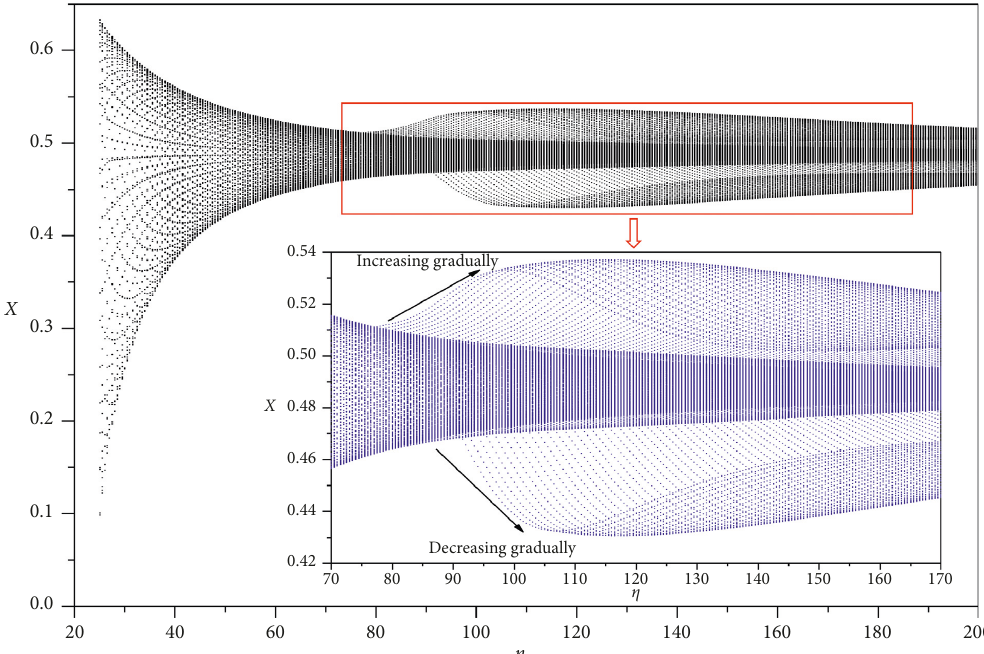
Figure 10: The bifurcation diagram of displacement X with frequency ratio η when